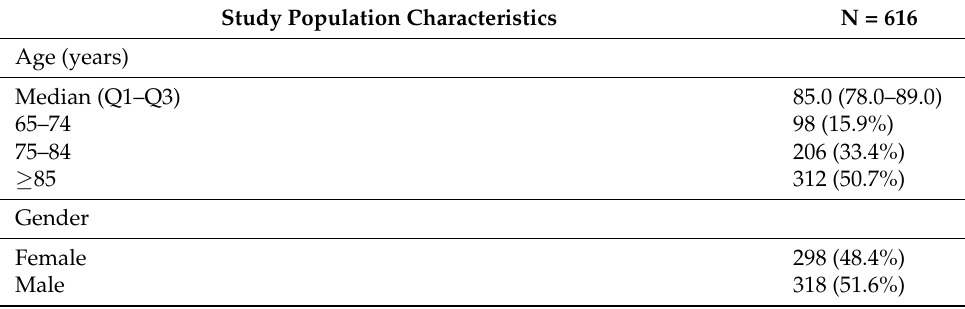
Table 1. Study population